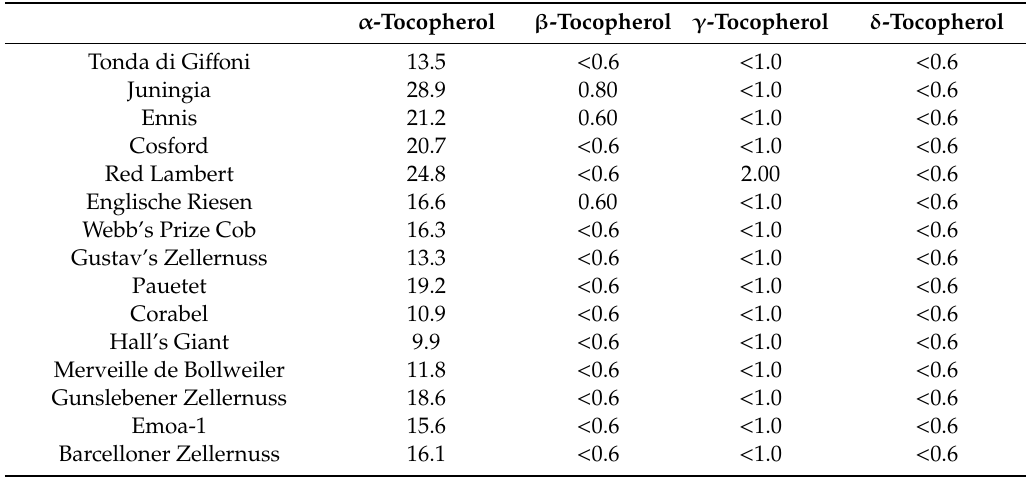
Table 3. Vitamin E content [mg / 100 g] of 15 hazelnut cultivars grown under identical conditions in Thuringia, Germany. α -Tocopherol β -Tocopherol γ -Tocopherol δ -Tocopherol Tonda di Gi ff oni 13.5 < 0.6 < 1.0 < 0.6 Juningia 28.9 0.80 < 1.0 < 0.6 Ennis 21.2 0.60 < 1.0 < 0.6 Cosford 20.7 < 0.6 < 1.0 < 0.6 Red Lambert 24.8 < 0.6 2.00 < 0.6 Englische Riesen 16.6 0.60 < 1.0 < 0.6 Webb’s Prize Cob 16.3 < 0.6 < 1.0 < 0.6 Gustav’s Zellernuss 13.3 < 0.6 < 1.0 < 0.6 Pauetet 19.2 < 0.6 < 1.0 < 0.6 Corabel 10.9 < 0.6 < 1.0 < 0.6 Hall’s Giant 9.9 < 0.6 < 1.0 < 0.6 11.8 < 0.6 Gunslebener Zellernuss 18.6 < 0.6 < 1.0 < 0.6 Emoa-1 15.6 < 0.6 < 1.0 < 0.6 Barcelloner Zellernuss 16.1 < 0.6 < 1.0 <